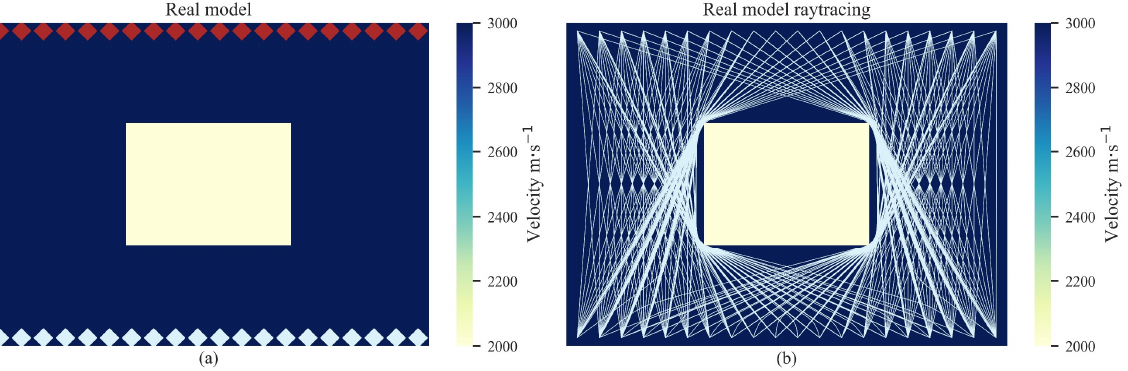
Figure 2. The real model ( a ) and its ray-tracing path ( b ) in the numerical experiments for the single cavity damage source. The red rhombuses represent the AE signal sources and the white rhombuses represent the receivers.